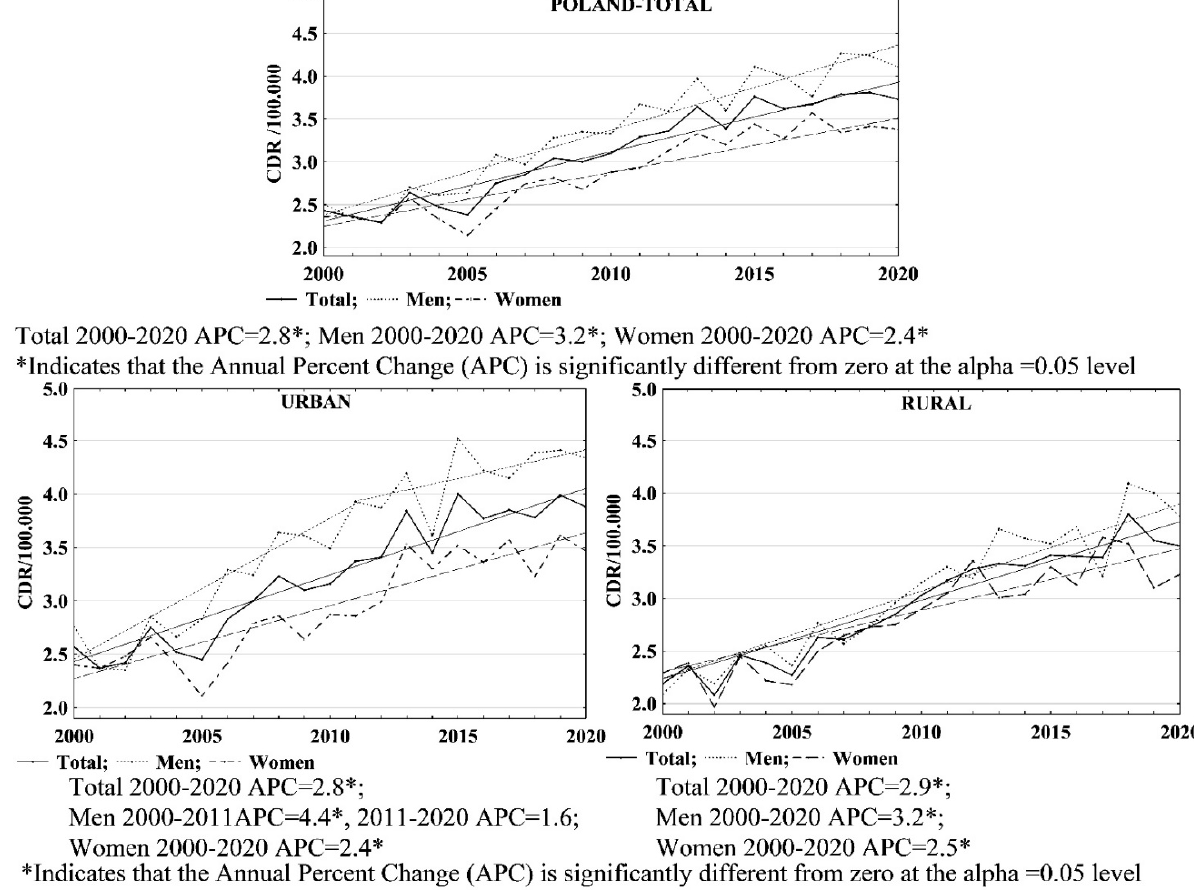
Figure 3. CDR due to skin melanoma by gender and place of residence in Poland in 2000–2020 .